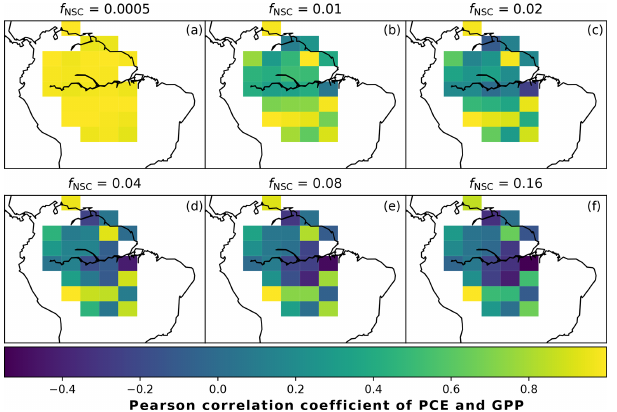
Figure 4. The Pearson correlation coefficient of simulated plant carbon expenditure (PCE) and driving Q 10 ( F Q ) for different ini- tialised carbohydrate contents as a fraction ( f NSC ) of grid box biomass. This gives an indication of how important a driver the Q 10 function is for PCE in each grid box.